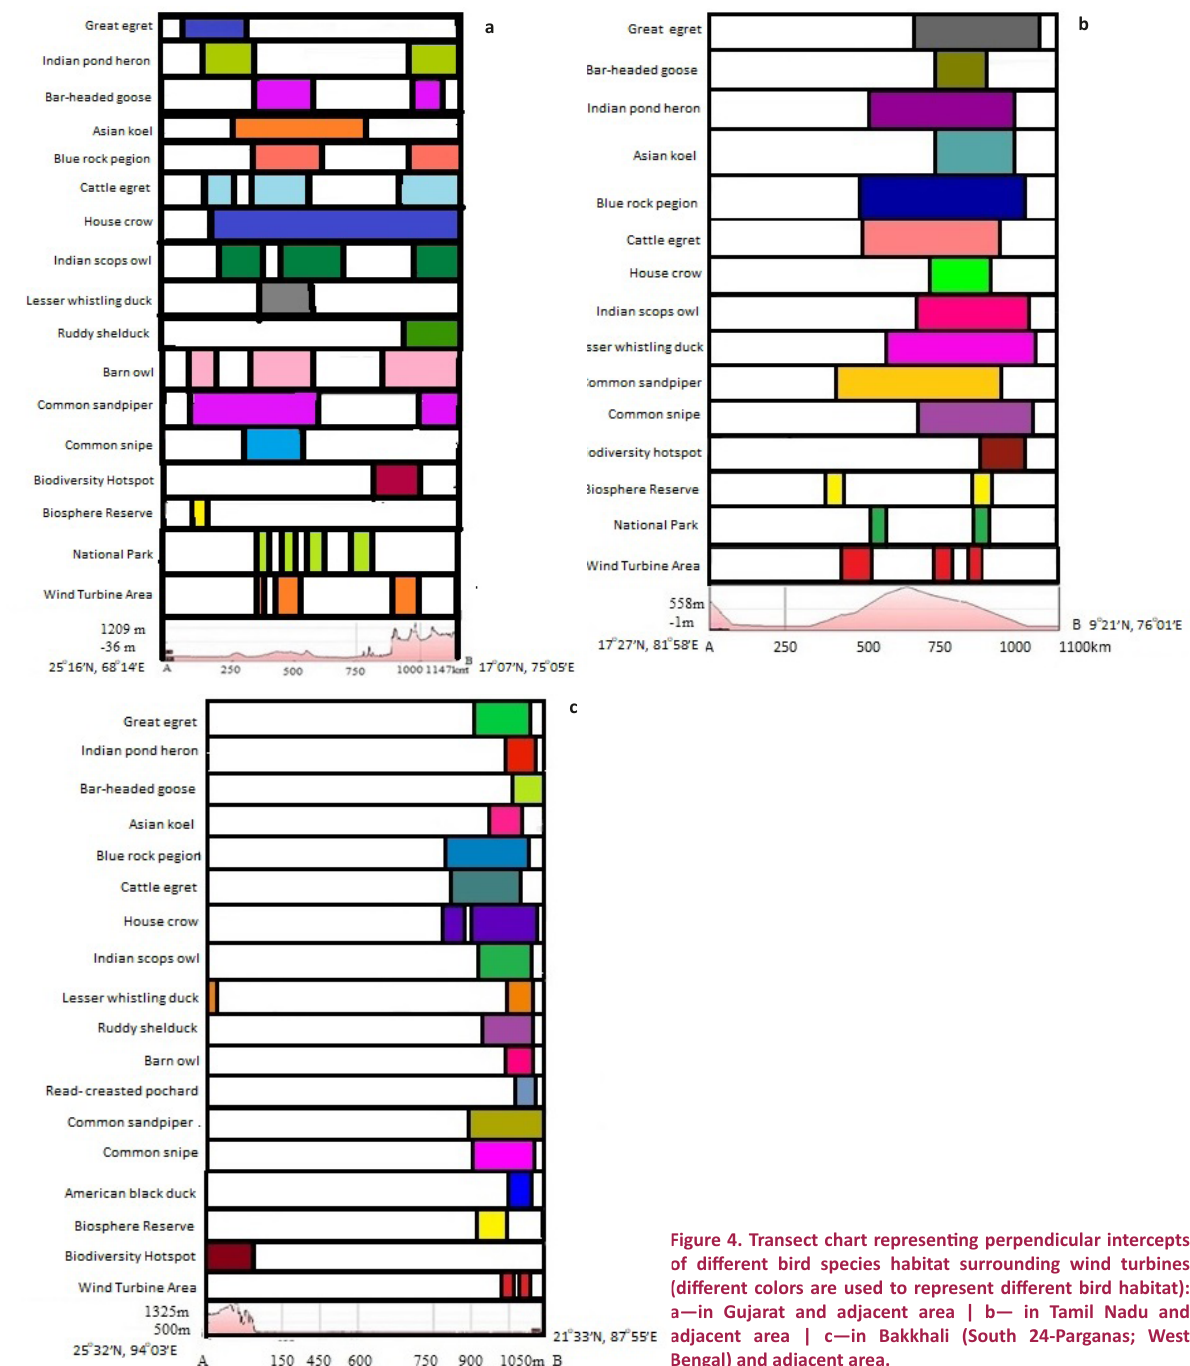
Figure 4. Transect chart representing perpendicular intercepts of different bird species habitat surrounding wind turbines (different colors are used to represent different bird habitat): a—in Gujarat and adjacent area | b— in Tamil Nadu and adjacent area | c —in Bakkhali (South 24-Parganas; West Bengal) and adjacent